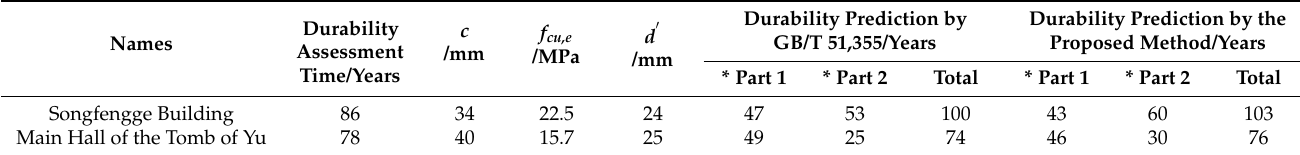
Table 4. The predicted durability lives from different calculation methods for the two